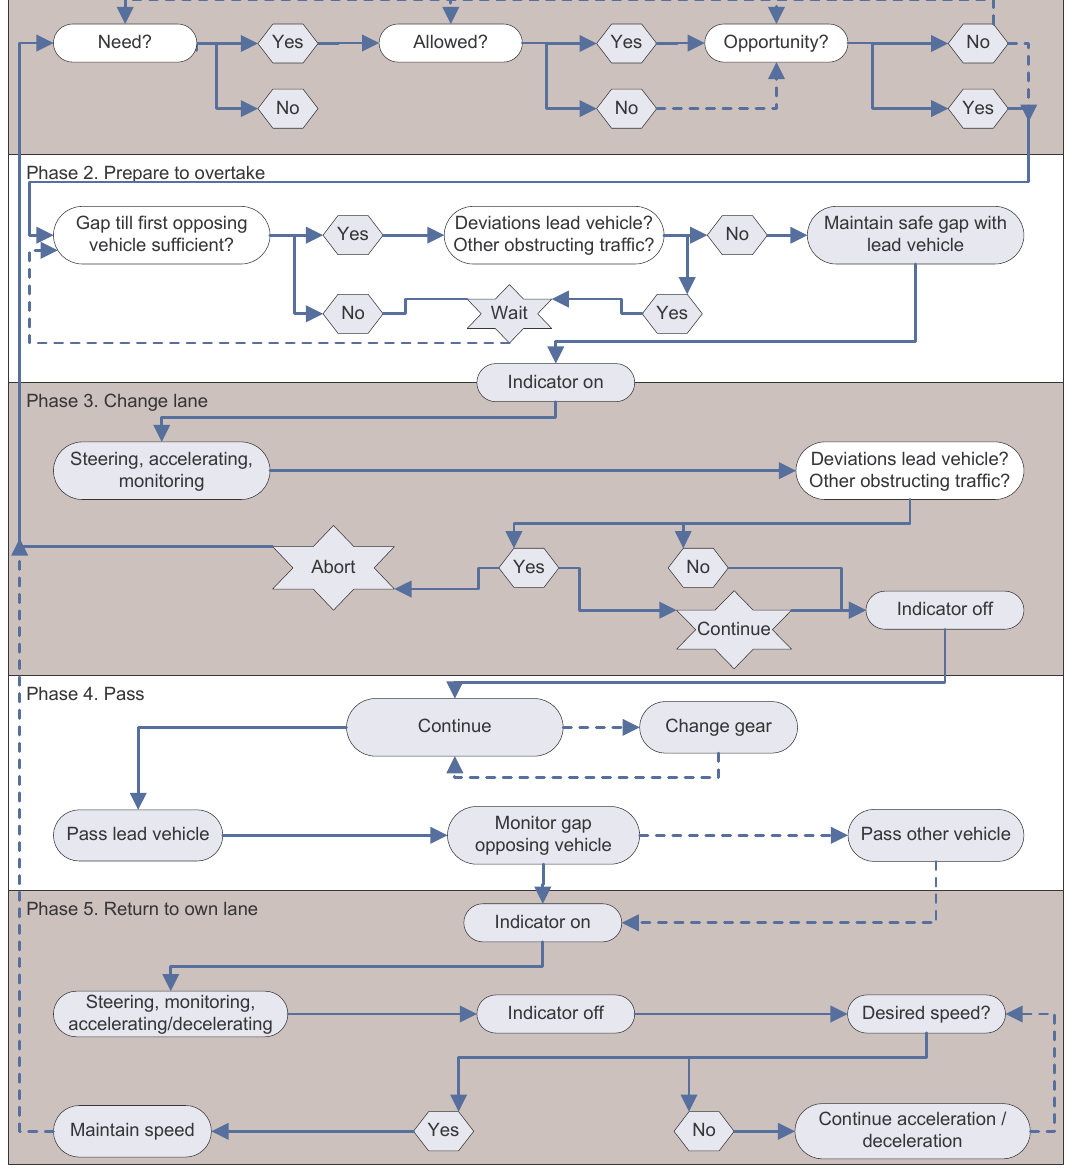
Figure 2. Task analysis of the overtaking task on roads with opposing